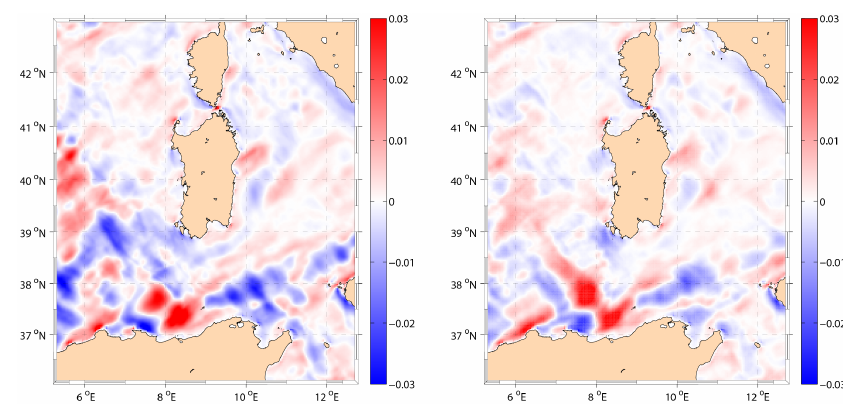
Figure 9. Reynolds stress covariance for BF (left) and BFC experiments. Units are m 2 s − 2 .